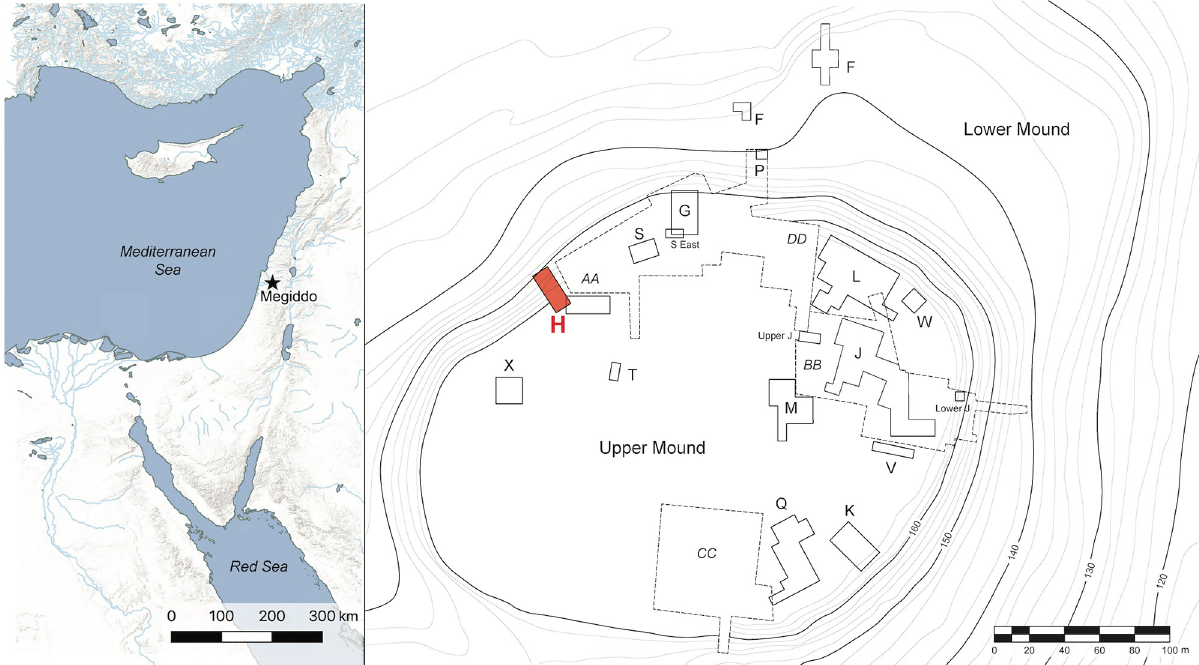
Fig 1. Map of the southern Levant and the site of Megiddo. On the left, the location of Megiddo in the southern Levant (Esri ArcGIS Pro, and Ancient World Mapping Center, “Waterway”; “Coastline” http://awmc.unc.edu/wordpress/map-files/ [Accessed: June 10, 2022], used under ODbL 1.0 and DbCL 1.0 licenses). On the right, the excavated areas at Megiddo, with Area H highlighted in red (plan courtesy of the Megiddo Expedition and presented here under a CC BY